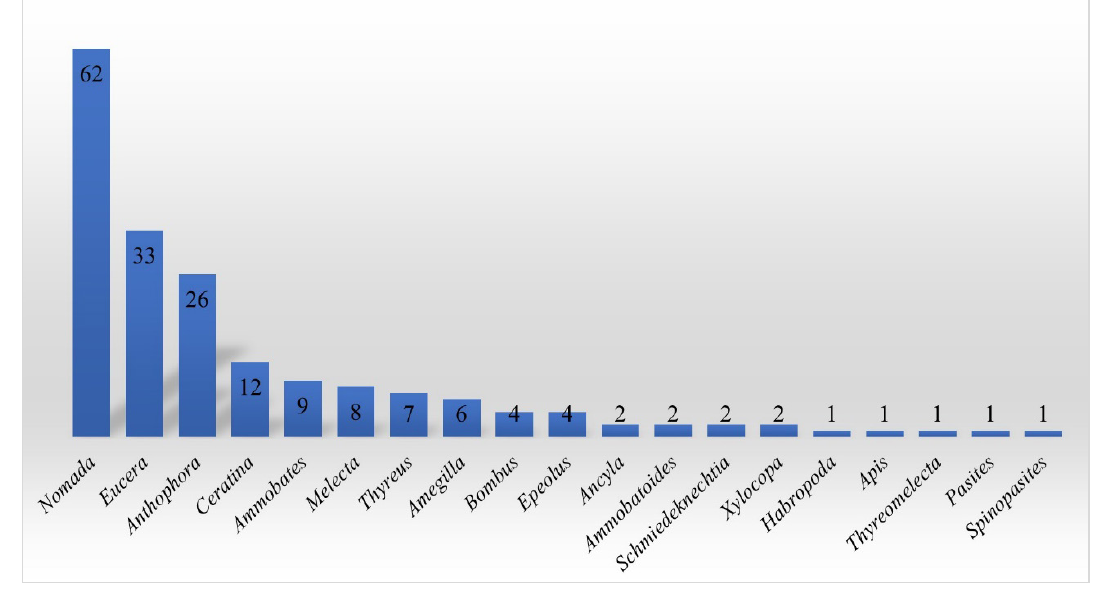
Fig 2. Apidae species number per genus in